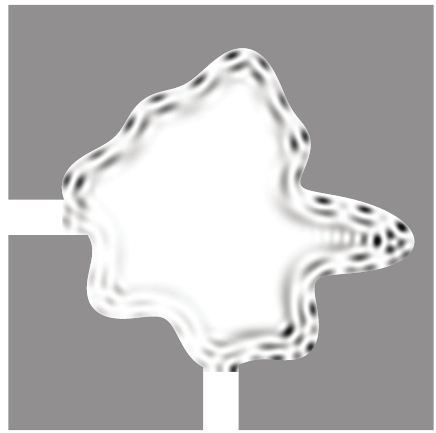
Figure 12: A contour plot of an electron density in a sample dot for √ 32 π , (cid:4) B = 16, and the fundamental mode Kd =